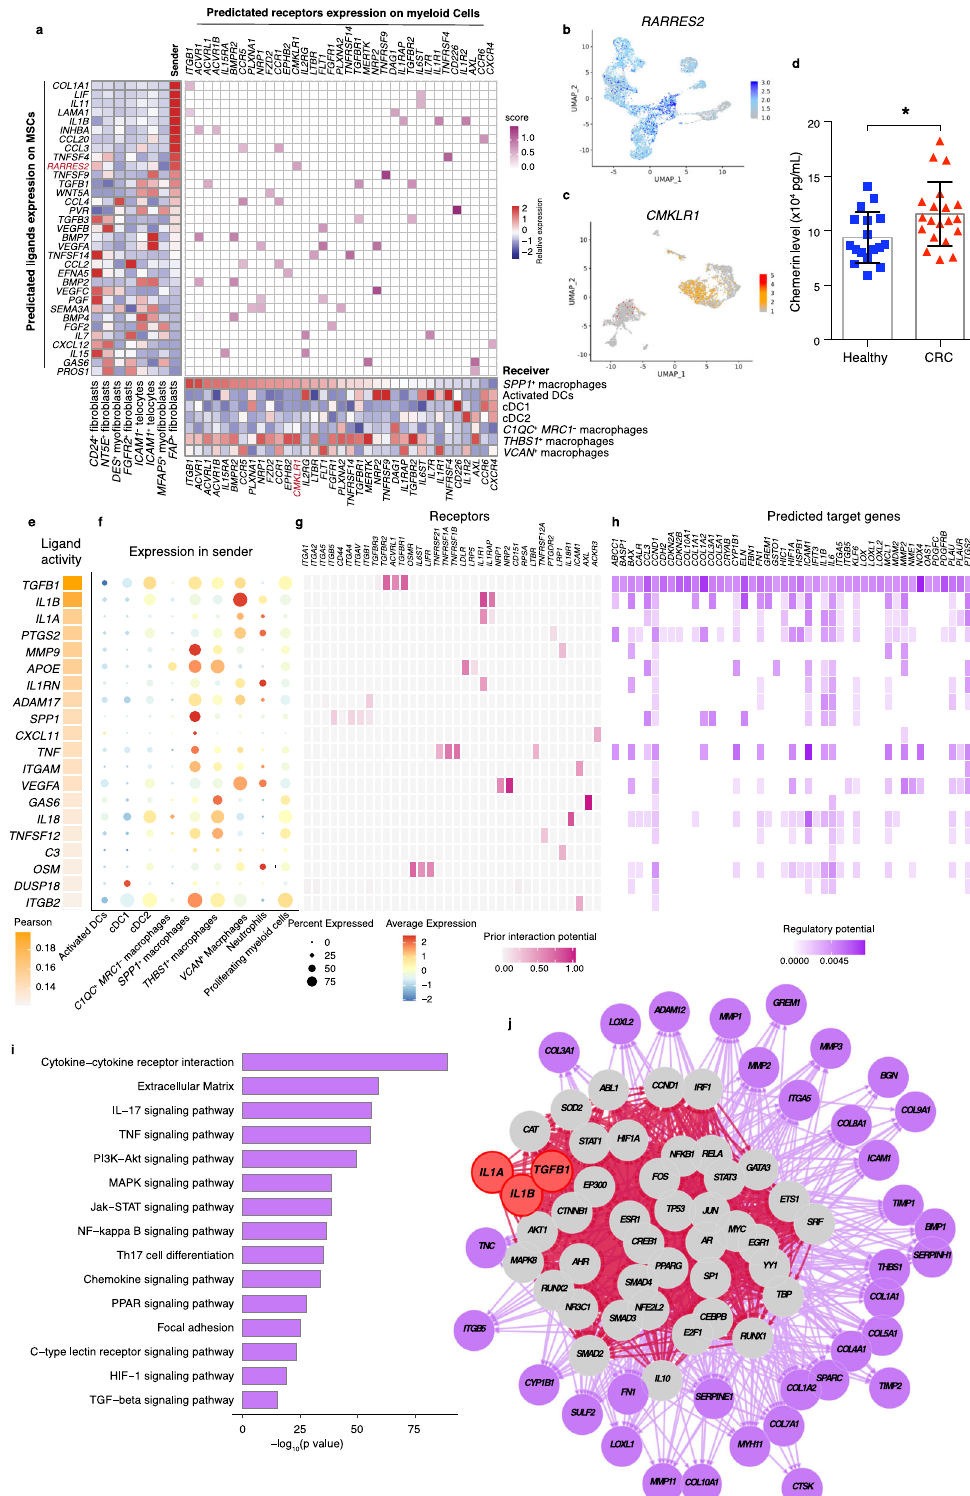
interaction between FAP + fi broblasts and SPP1 + macrophages should be considered as a target for CRC treatment. Together, these fi ndings imply that FAP + fi broblasts and SPP1 + macrophages contribute to ECM remodeling and coordinate to form a desmoplastic microenvironment that prevents lymphocytes in fi l- trating the tumor core, further reducing the ef fi cacy of PD-L1 treatment (Fig. 8j). We propose that, mechanistically, FAP